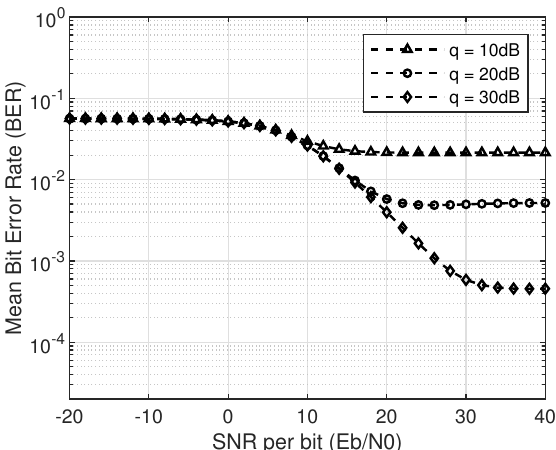
Figure 7. Comparison of average BER for 16-QAM with different values of interference temperature ( q = 10,20,30 dB).